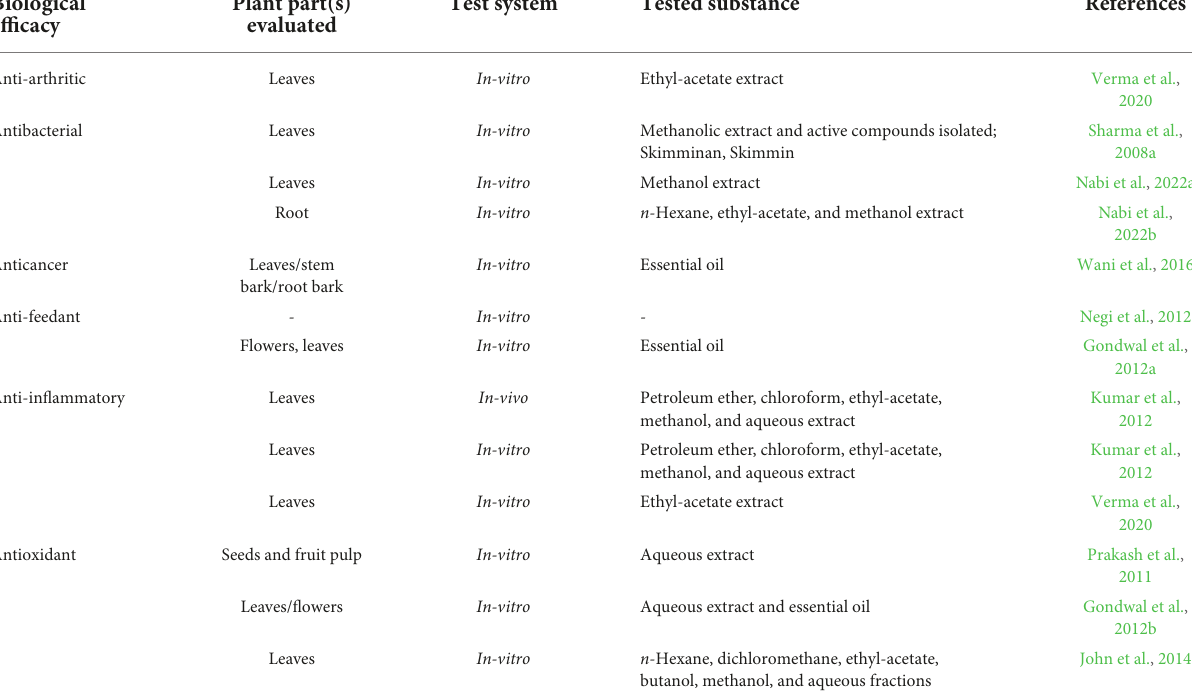
TABLE 3 Summary of bioefficacy of Skimmia anquetilia